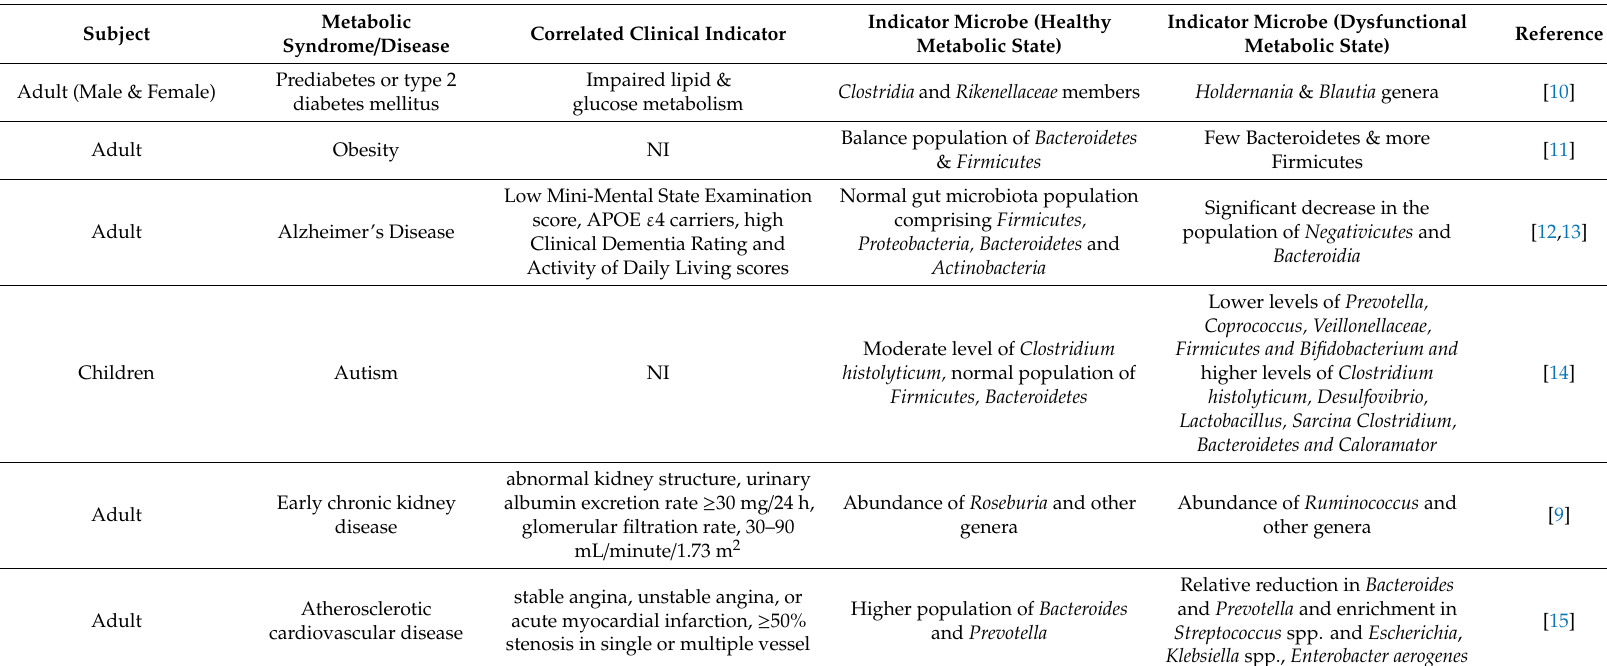
Table 1. Summary of Diseases / Metabolic Syndrome, Microbial Indicators of Healthy and Dysfunctional